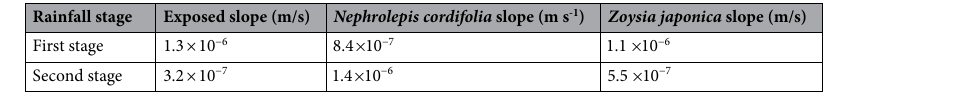
Table 6. Equivalent permeability